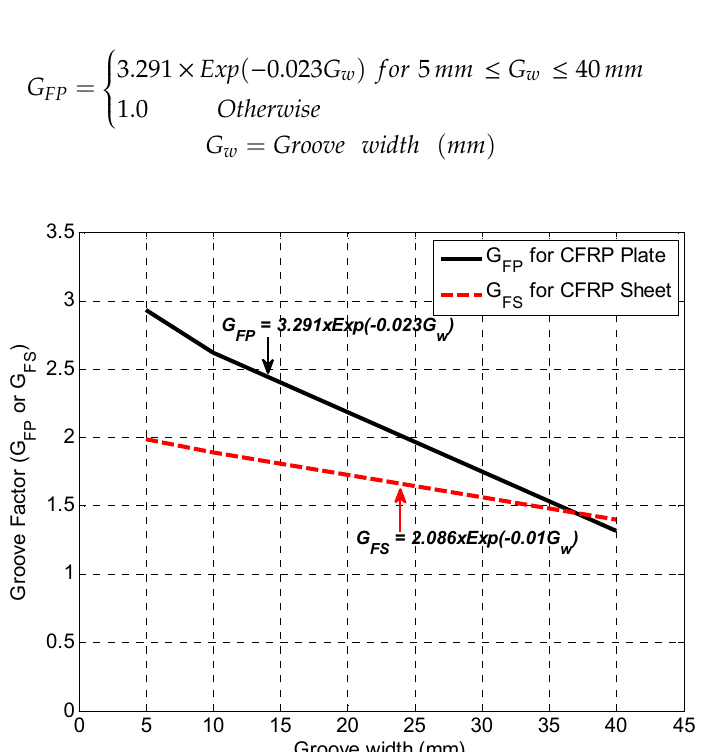
Figure 14. Groove Factors (GFP and GFS) for CFRP plats and sheets on groove-epoxy.